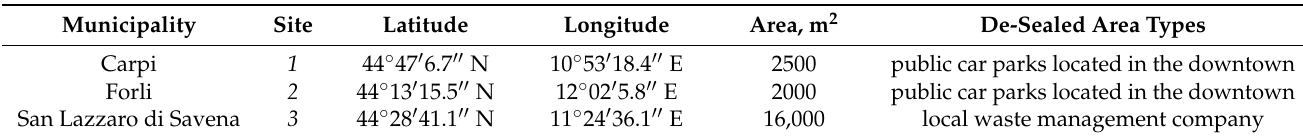
Table 1. Location of the de-sealing